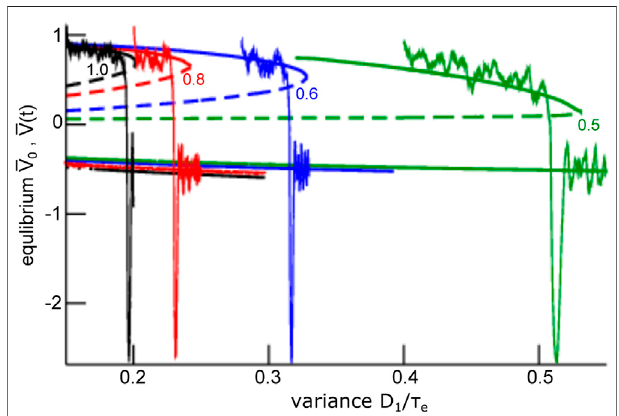
FIGURE 7 | Equilibria and representative time series of the global mode V ( t ) for the zero-mean partial stimulation. There is a bistability and saddle- node bifurcation from a stable node to an stable focus at enhanced noise intensity. The numbers denote the values of the stimulus ratio q . Solid (dashed) lines mark stable (unstable) states. The time series V results from the time-varying noise intensity according to Eq. 7 .